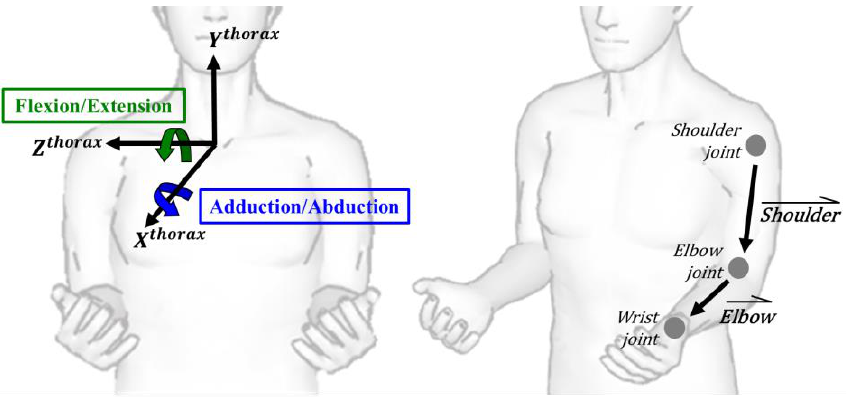
Figure 2. The thorax coordinate system and definition of movements.